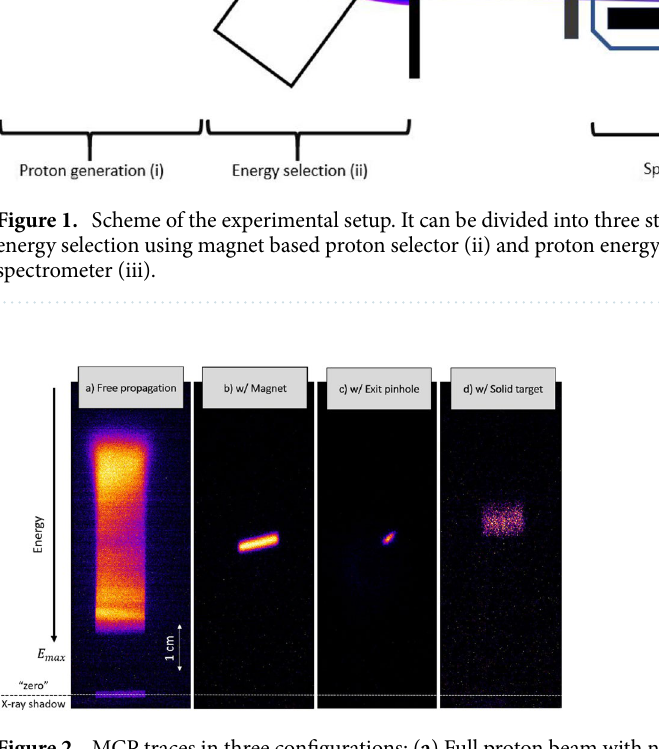
Figure 2. MCP traces in three configurations: ( a ) Full proton beam with no magnetic selector in (full TNSA spectrum). ( b ) Partial selection magnetic selector in with only the 20 µ m entrance slit. ( c ) Full selection with 20 µ m entrance slit and 20 µ m exit pinhole). ( d ) Selected beam ( c ) after passing through a solid 2 µ m Mylar